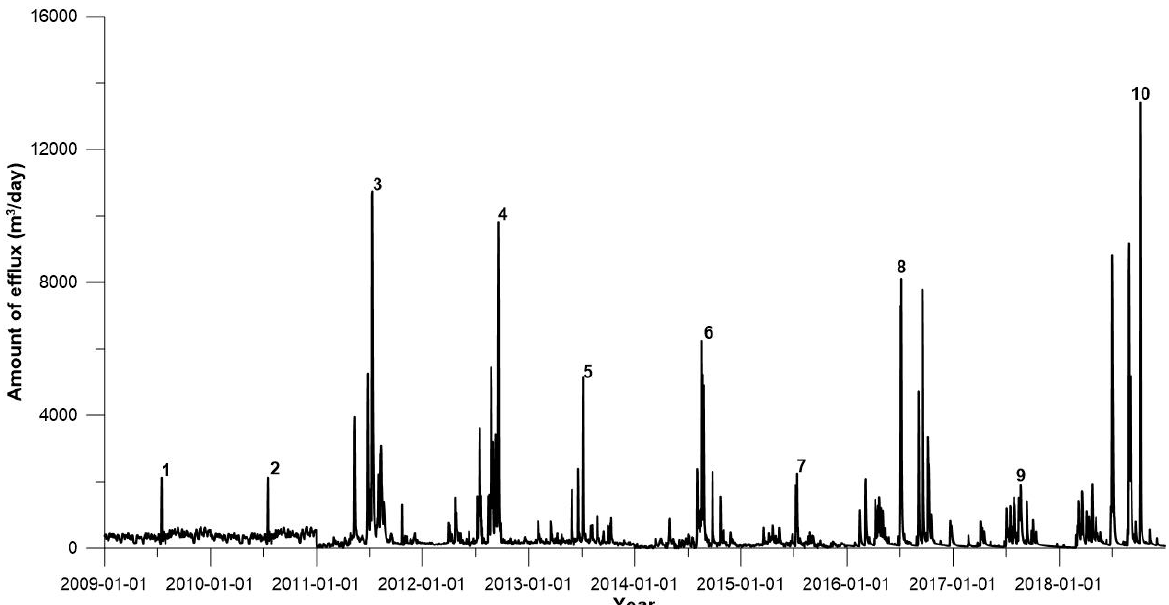
Figure 3. Streamflow in the Nakdong River watershed from 2009 until 2018. The numbers indicate the peaks for estimating baseflow.